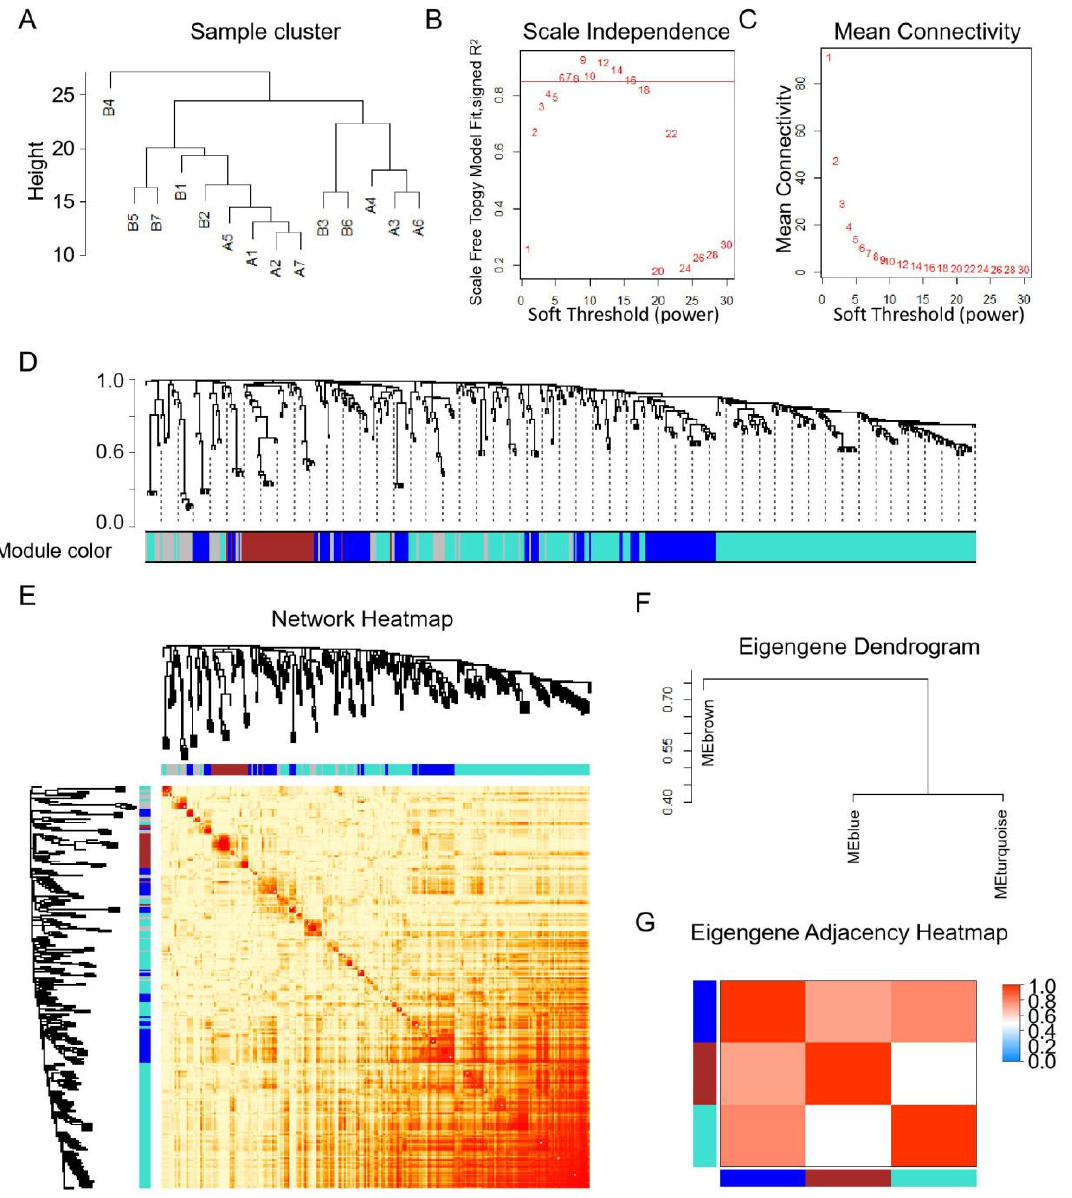
Figure 5. WGCNA of miRNAs before and after transportation. ( A ) Samples clustering analysis of before and after transportation. ( B ) Scale independence of co-expression. ( C ) Mean connectivity of co-expression. ( D ) Cluster dendrogram of miRNAs. ( E ) Network heatmap of DEMs. ( F ) Eigengene dendrogram of modules. ( G ) Eigengene adjacency heatmap.